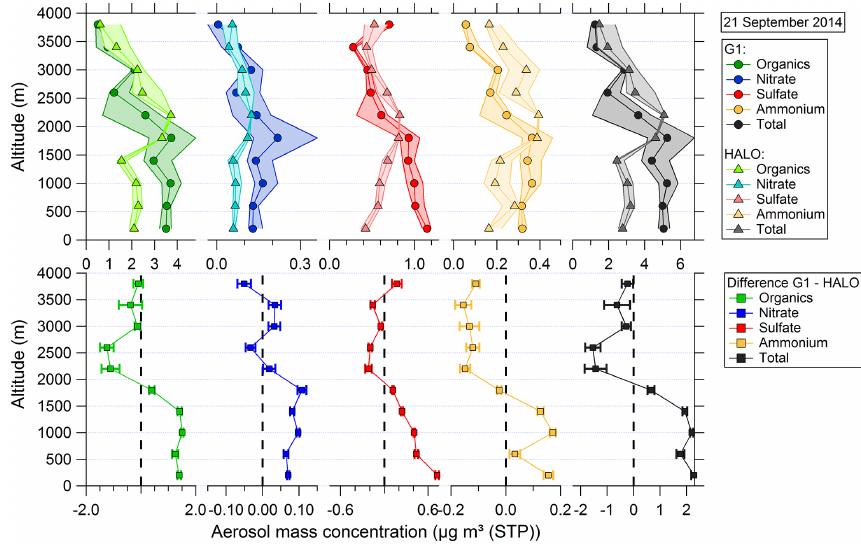
Figure 11. The vertical profile of aerosol mass concentration measured by the G1 and HALO AMS on 21 September.